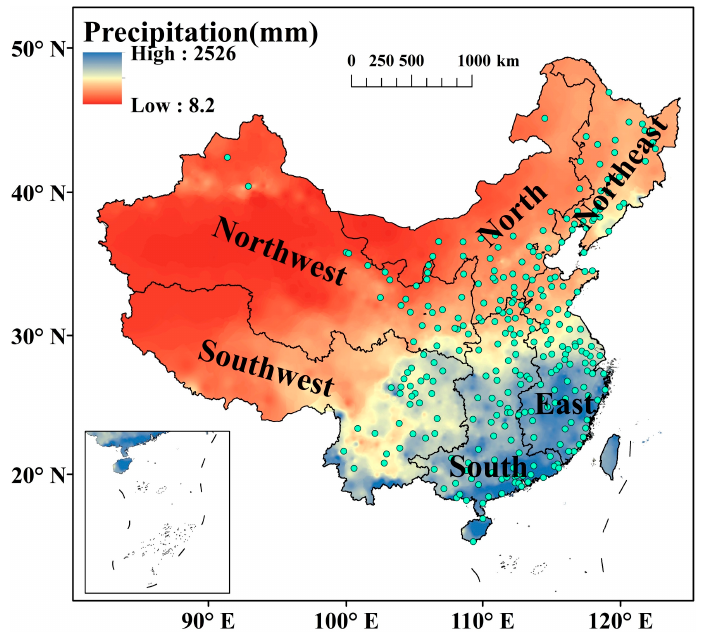
Figure 1. Geolocation of the selected 281 cities and six regions (Northwest, North, Northeast, East, South, and Southwest) of China in this study. The background information is annual precipitation across China.